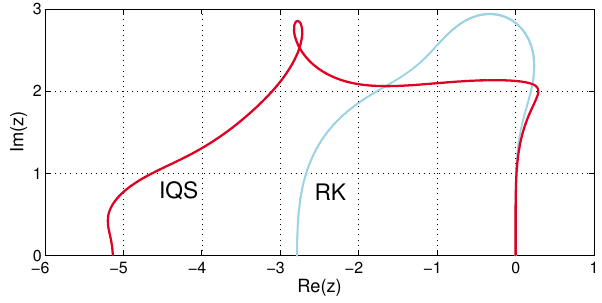
Figure 3. Stability regions of RK method of order p = 4 and GLMs with s = r = p = 4, q = 3 with